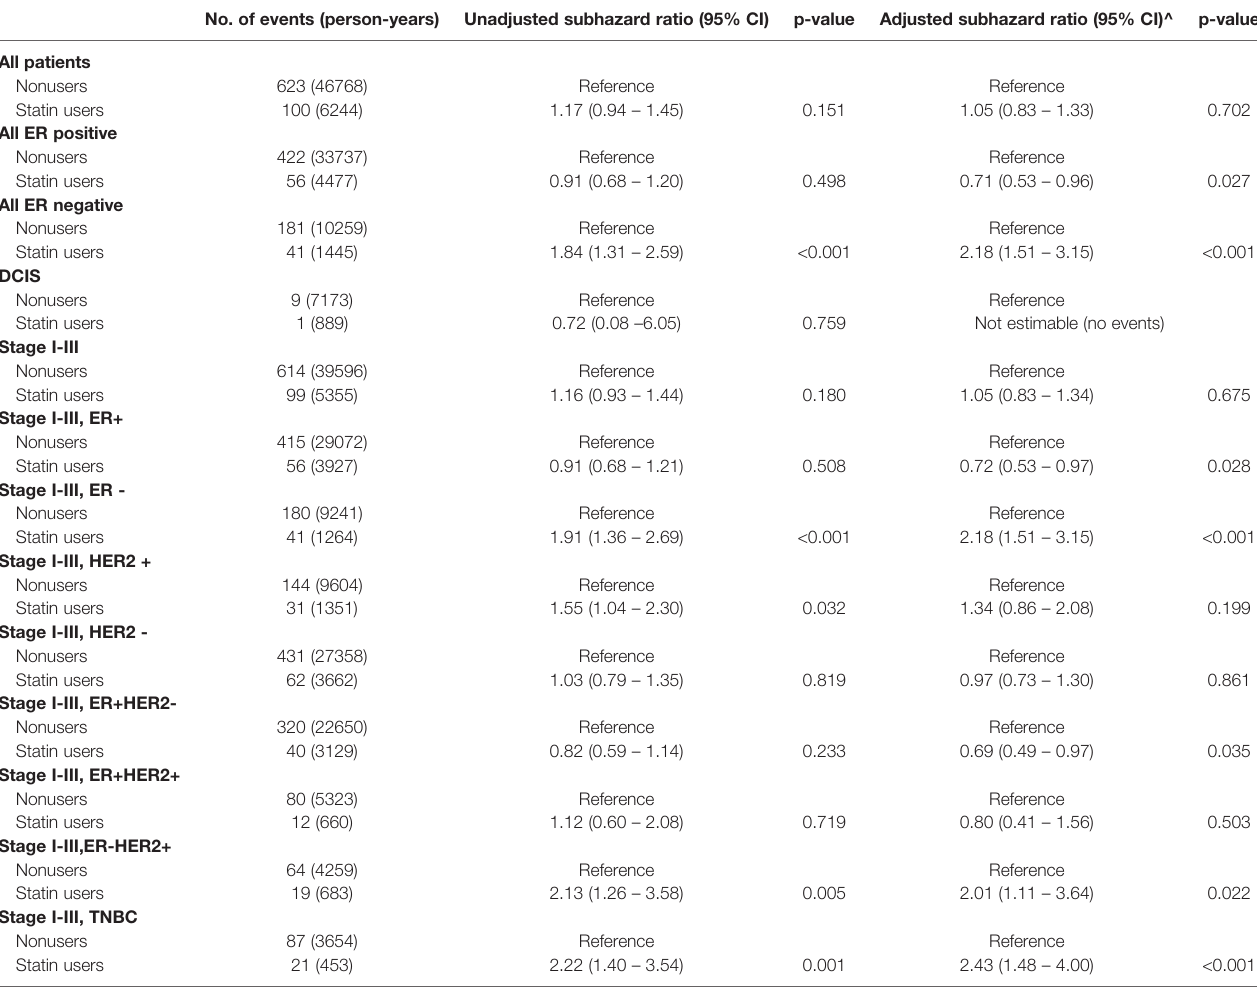
TABLE 3 | Unadjusted and adjusted subhazard ratios for disease-speci fi c survival by statin use in different subsets of patients.